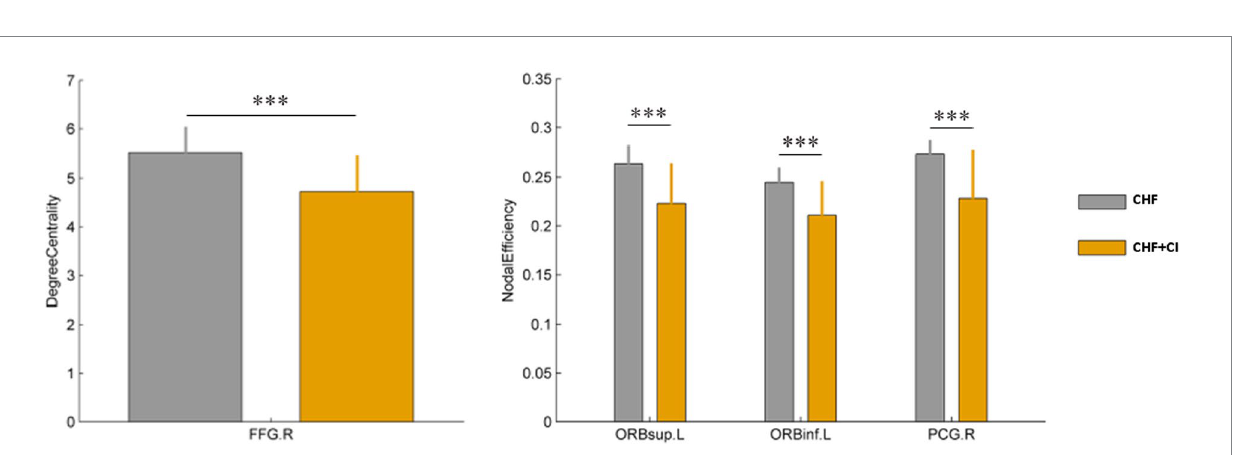
FIGURE 2 Differences in the local network measures of subcortical structures between two groups, including nodal degree centrality and nodal efficiency (*** p < 0.001, FEW